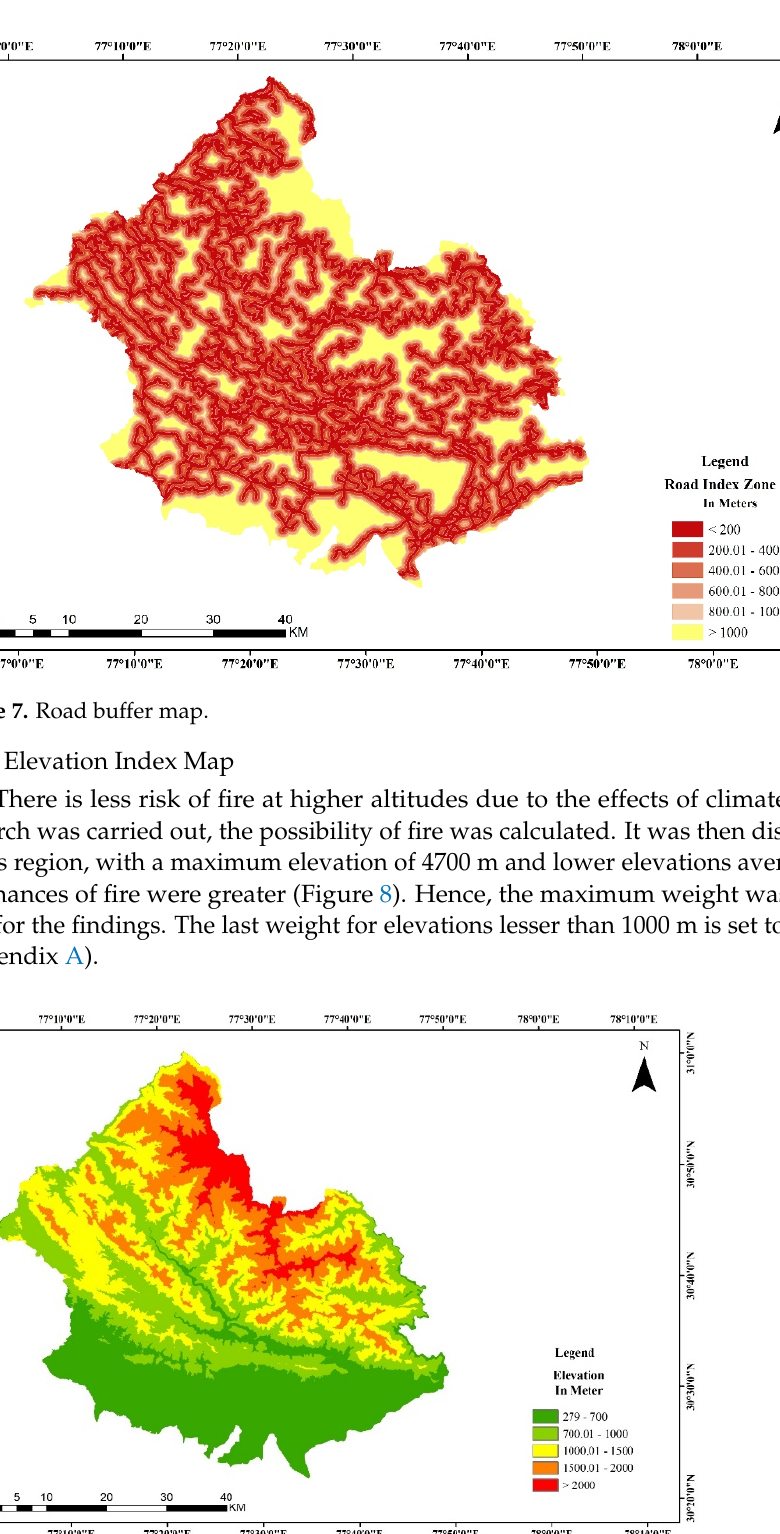
Figure 6. Slope map.